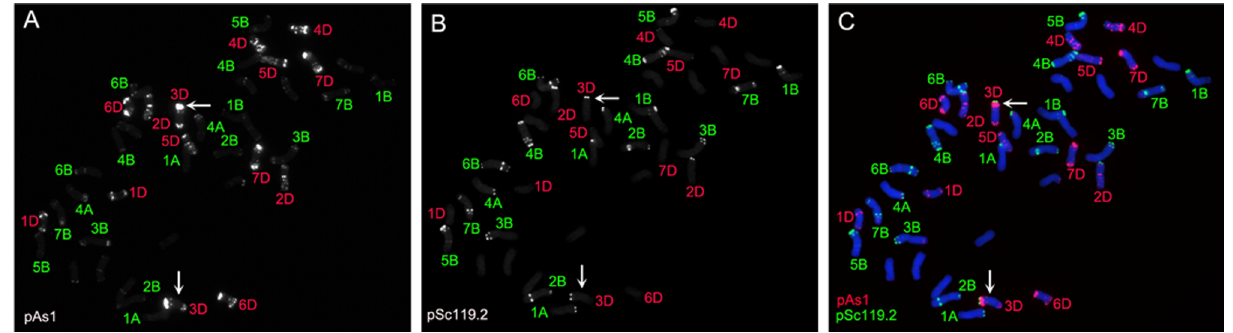
Figure 1. FISH was performed using pAs1 (red) and pSc119.2 (green) as probes on mitotic chromosomes of ‘Mianyang11’. A pAs1 FISH signals on chromosomes of ‘Mianyang11’, the DAPI-stained chromosomes were converted into a black and white image. B pSc119.2 FISH signals on chromosomes of the same cell in A, the DAPI-stained chromosomes were converted into a black and white image. C Merged image of A and B. Arrows indicate 3D chromosomes with pSc119.2 FISH signals. Chromosomes were counterstained with DAPI (blue).